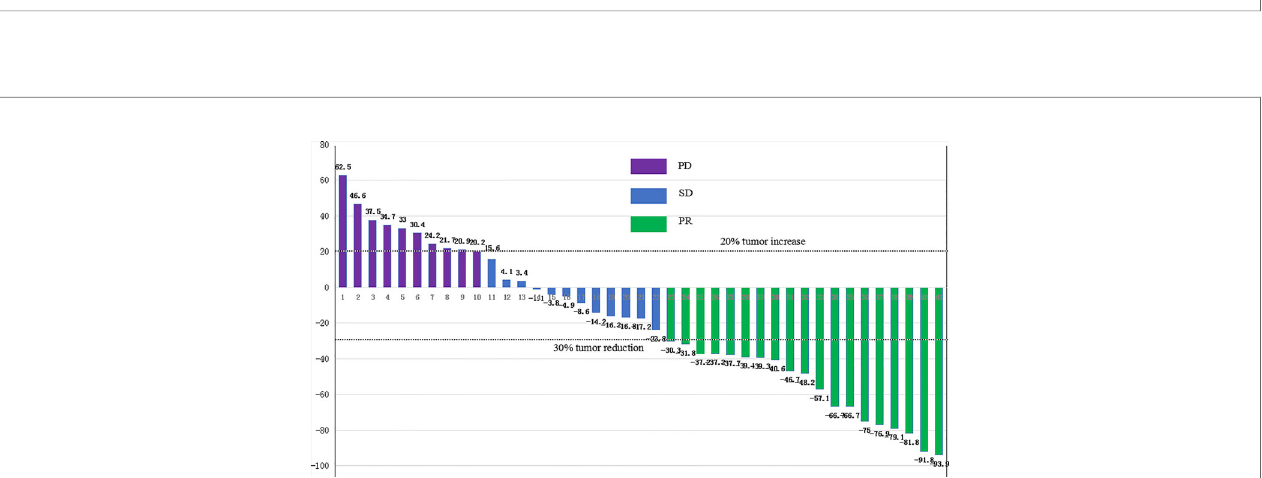
FIGURE 3 | Kaplan – Meier curves showing overall survival (OS). (A) OS for the whole group; (B) OS by LN metastasis subgroups; (C) OS by PD-L1 TPS expression subgroups; (D) OS by tumor remission subgroups; (E) OS by different treatment subgroups. TACE, transarterial chemoembolization; RT, radiation therapy; TPS, tumor proportion score; LN, lymph node.